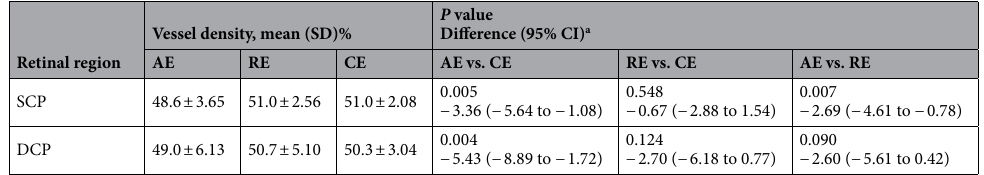
Table 3. Macular vessel density in amblyopic eyes, recovered amblyopic eyes and control eyes. Unless otherwise indicated, data are expressed as mean (SD) percentage of macular vessel density. DCP deep retinal capillary plexus, SCP superficial retinal capillary plexus, SD standard deviation. a Difference (95% CI) and P value were adjusted for axial